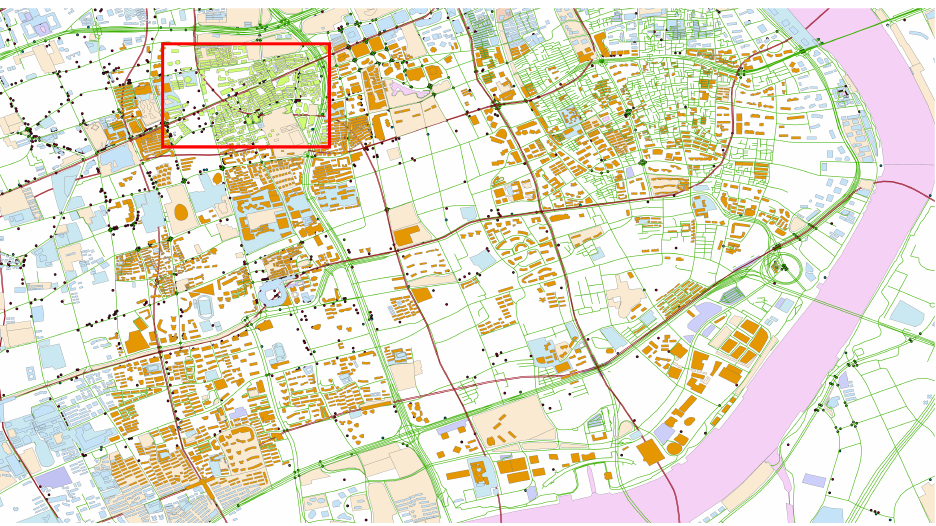
Figure 5. The selected area from Open Street Map, which is a part of the urban area of Shanghai, China. Using the WGS84 coordinate system, this area is in the extent of 31.225670 dd ( Up ), 31.225670 dd ( Down ), 121.452669 dd ( Left ), and 121.498787 dd ( Right